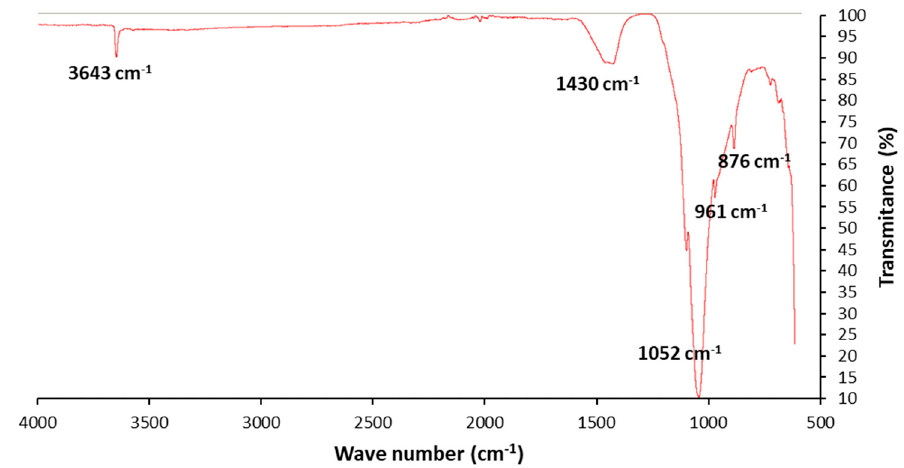
Figure 5. Fourier transform infrared (FTIR) spectrum of poultry ash.